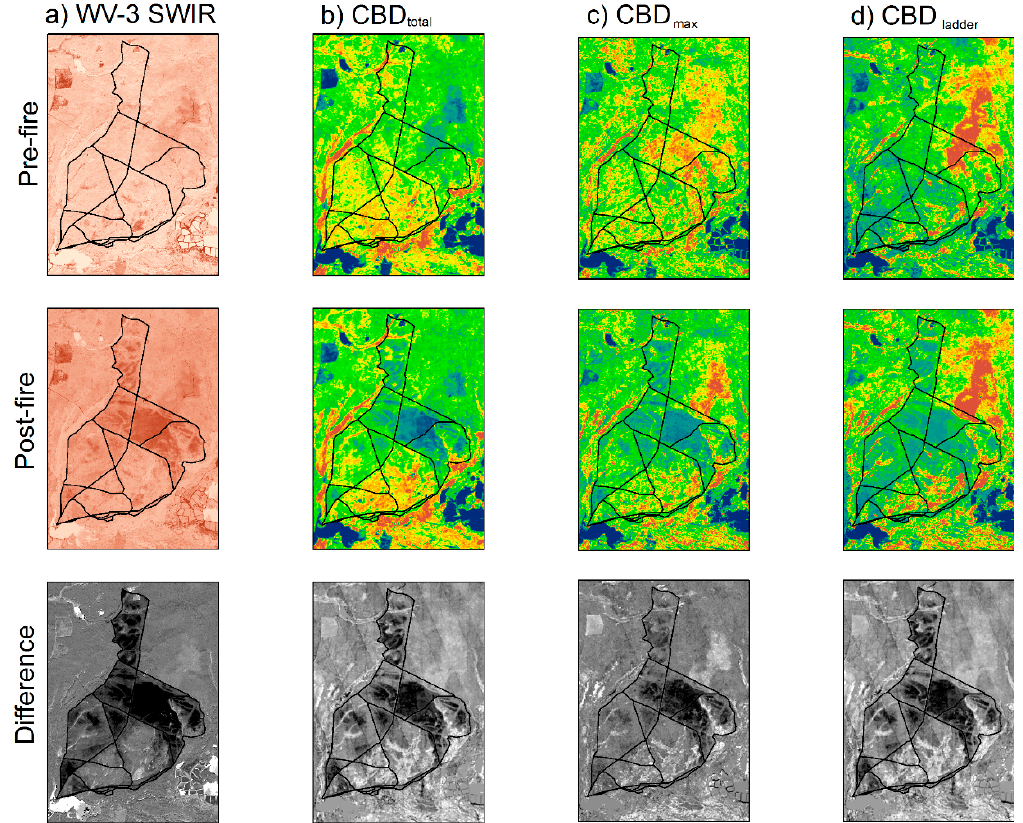
Figure 1. Remote sensing products of the study area. Pre-fire, post-fire, and the difference of these images. Column ( a ): WV-3 SWIR band 5 (2145–2160 nm). Remaining columns are Airborne Laser Scanning (ALS)-derived canopy profile summary metrics: ( b ) CBD total , ( c ) CBD max , and ( d ) CBD ladder . For the canopy profile metrics, low values are in blue and green, high values in yellow and red. For the difference images, dark tones represent large changes; light tones represent minimal change.